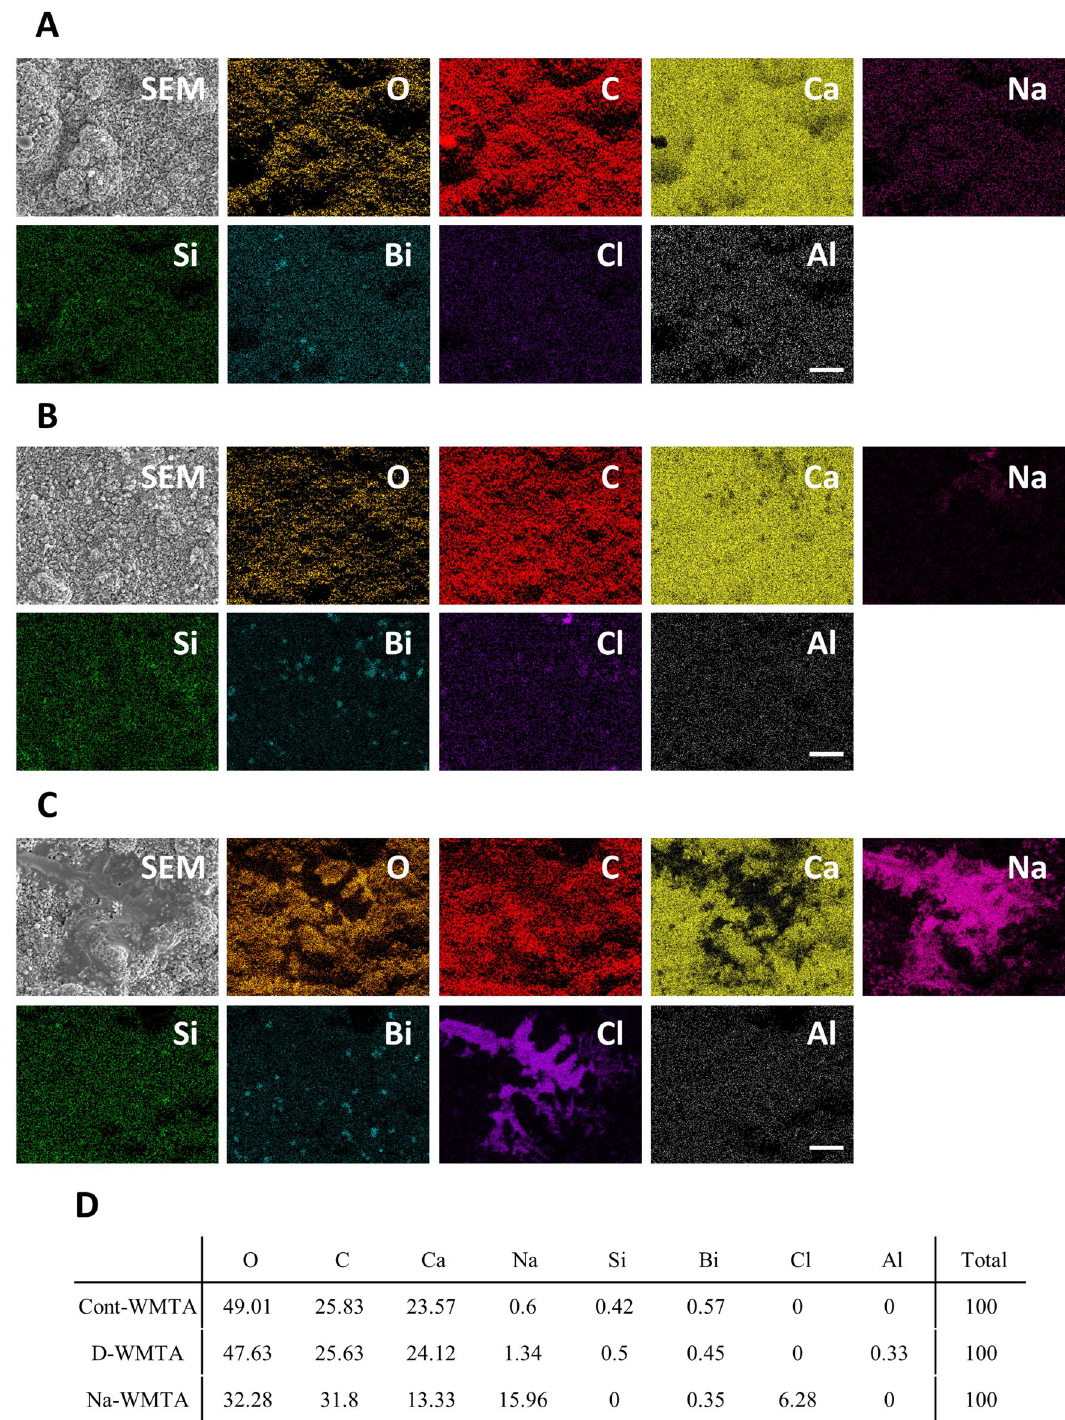
Figure 3. Elemental mapping by energy-dispersive X-ray analysis of WMTA discs immersed in NaOCl. EDX elemental mapping micrographs of Cont-WMTA ( A ), D-WMTA ( B ), and Na-WMTA ( C ). SEM, SEM micrographs; O (orange); C (red); Ca (yellow); Na (pink); Si, (green); Bi, (blue); Cl, (purple); Al, (white). Original magnification: ×1000. Bars = 20 µm. ( D ) Atomic percentage (At%) of Cont-WMTA, D-WMTA, and